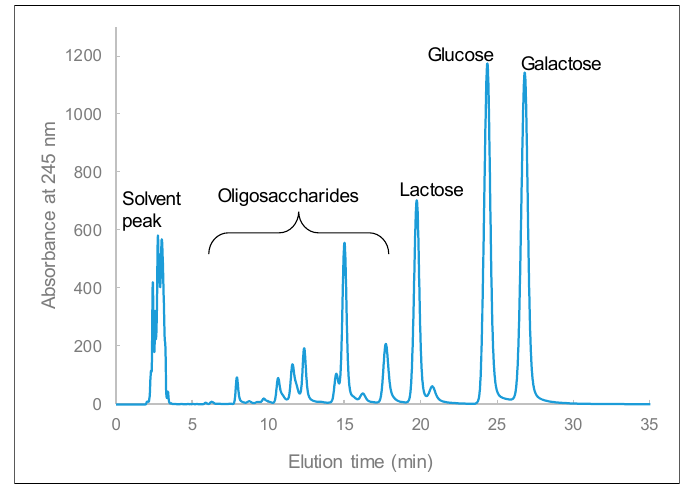
Figure 10. Chromatographic profile of products from lactose hydrolyzed by crude β -galactosidase, for 4 h under the following conditions: using 500 μ L of 20% ( w / v ) lactose and 100 μ L of crude enzyme sample (23.13 U/mg specific activity with o -nitrophenol- β - D -galactopyranoside (ONPG) as the substrate), pH = 5.5, and 37 °C.